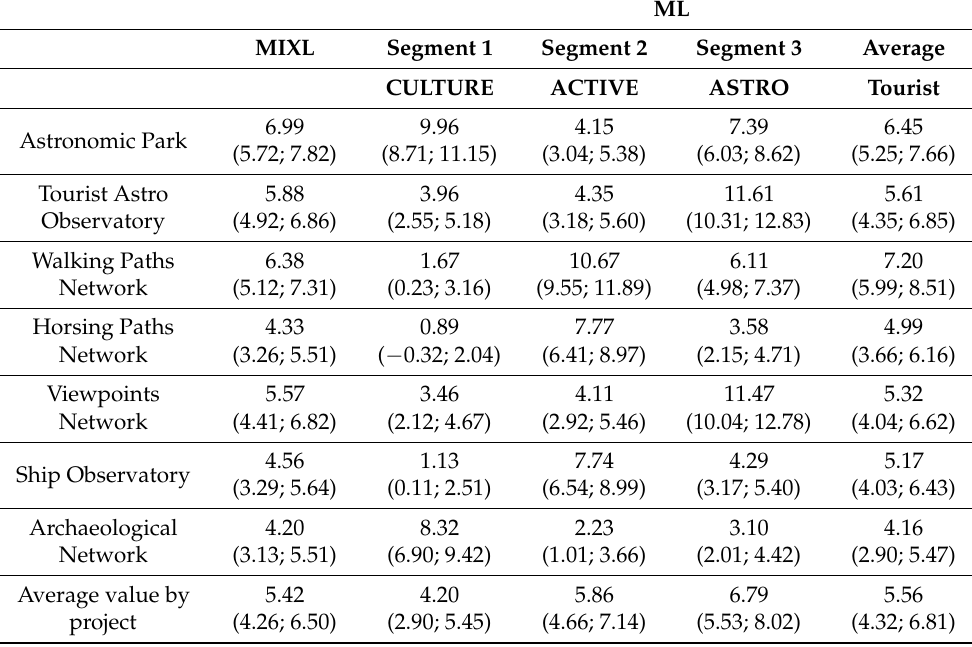
Table 4. Willingness to pay (Euros) for the stargazing projects (confidence intervals in